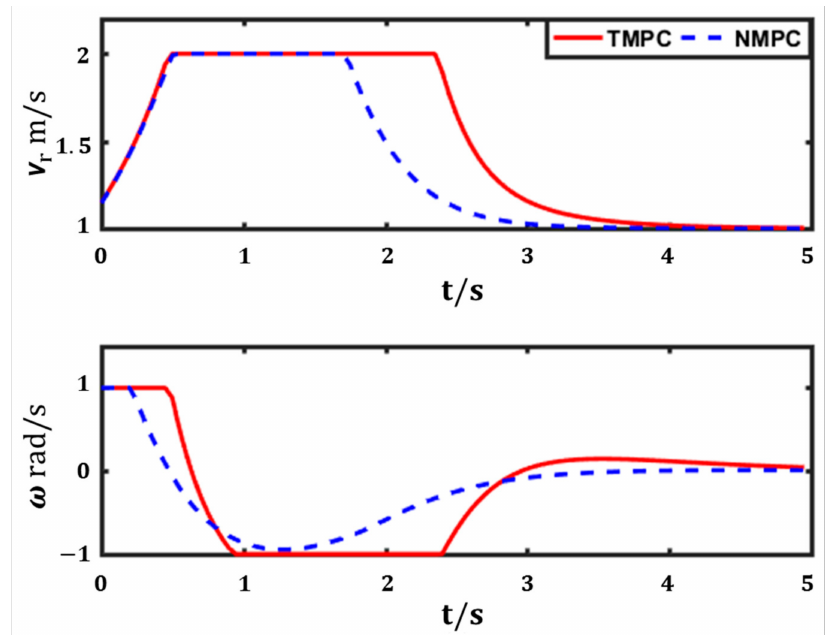
Figure 5. The control input of the TMPC and NMPC controllers under the ST.